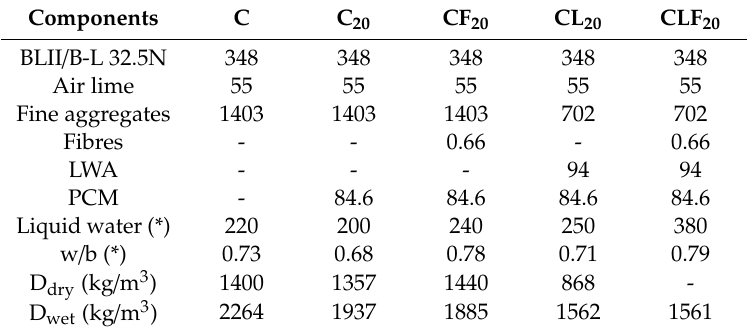
Table 1. Compositions of PCM cement-lime mortars, components in kg (adapted from